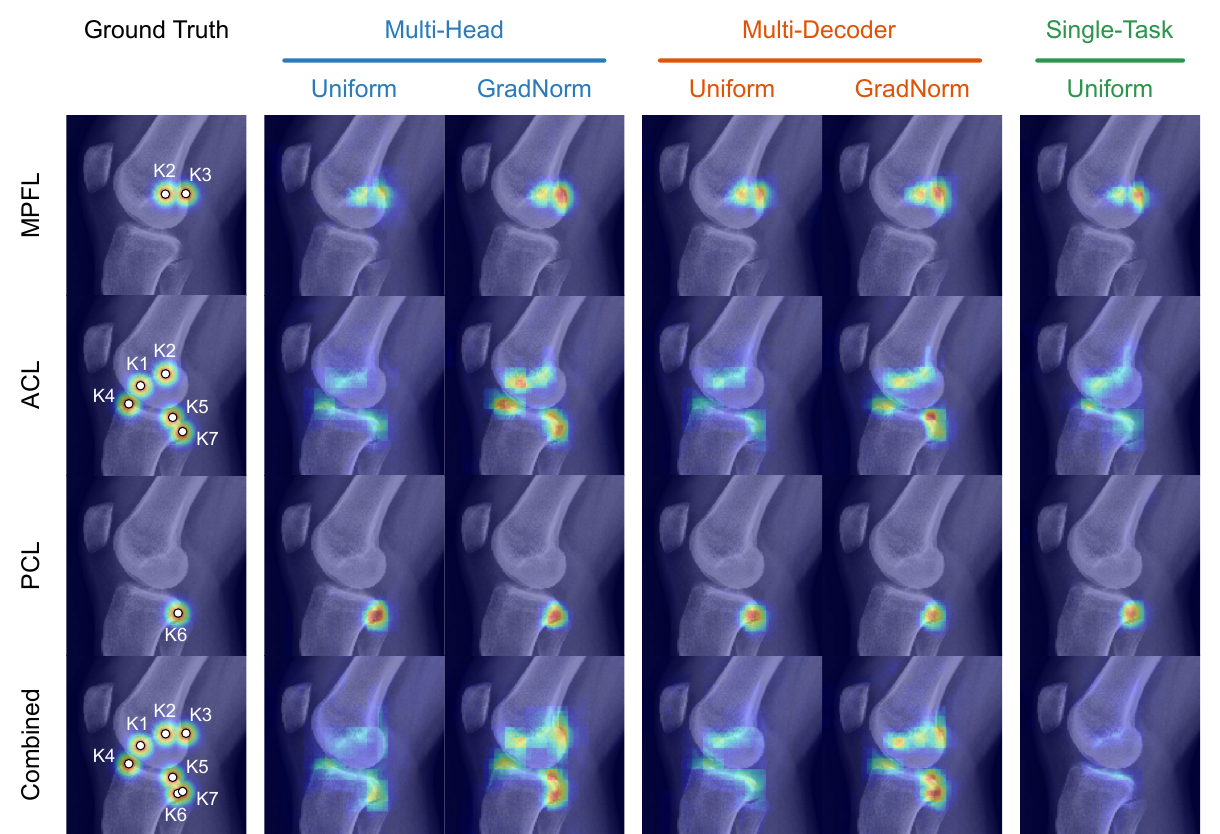
Figure 5. Visualization of heatmap prediction quality for different model topologies and task weight- ing strategies for a random sample from the test